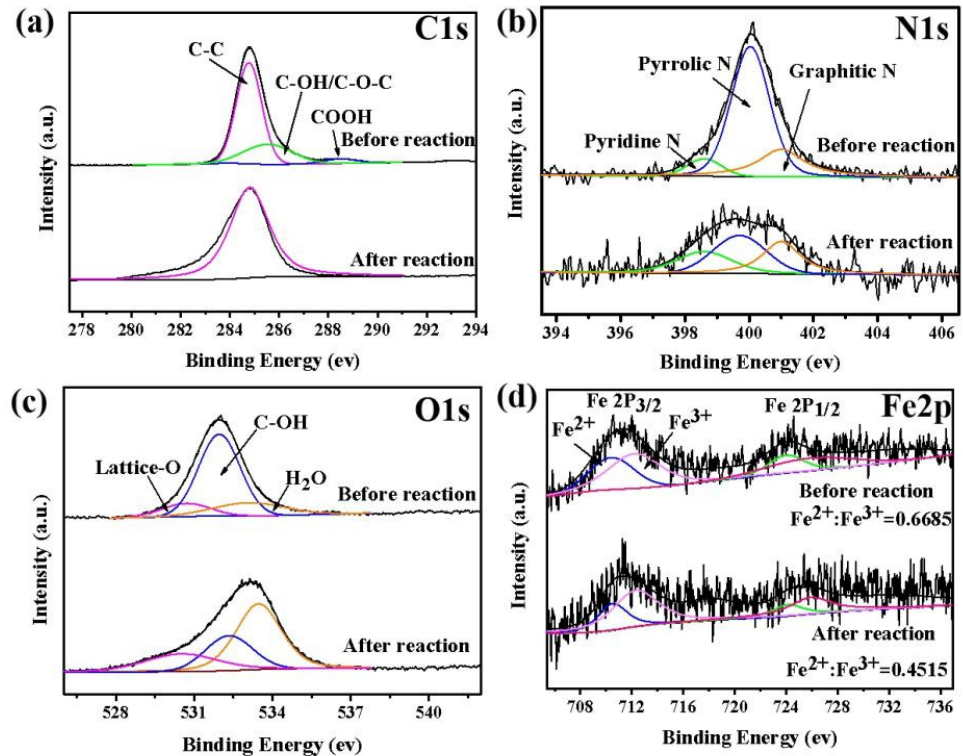
Figure 6. The XPS spectra of C 1s ( a ), N 1s ( b ), O 1s ( c ), and Fe 2p ( d ) before and after reaction in the E/Fe–N–BC/PMS system.(( a ) pink line: C–C, cyan line: C–OH/C–O–C, blue line: –COOH. ( b ) orange line: graphitic N, cyan line: pyridine N, blue line: pyrrolic N. ( c ) red line: lattice O, cyan line: C–OH, blue line: H 2 O. ( d ) pink and cyan line: Fe 2+ ; blue and red line: Fe 3+ )